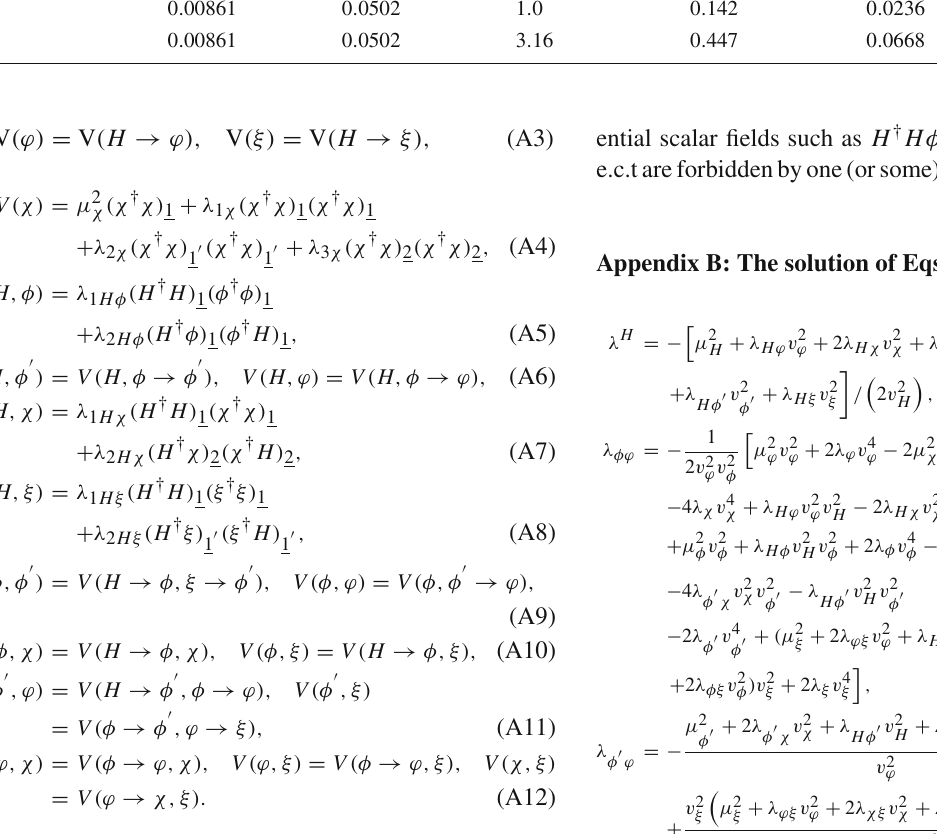
with s 34 ∈ ( 0 . 025 , 0 . 178 ) and (cid:4) m 2 41